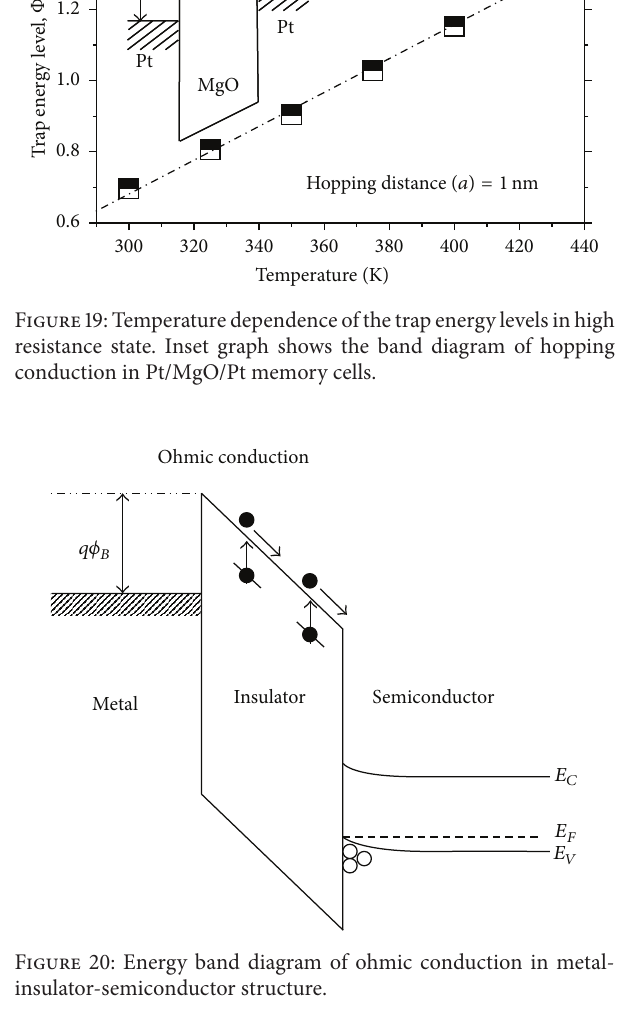
the effective density of states of the conduction band; the other terms are as defined above.